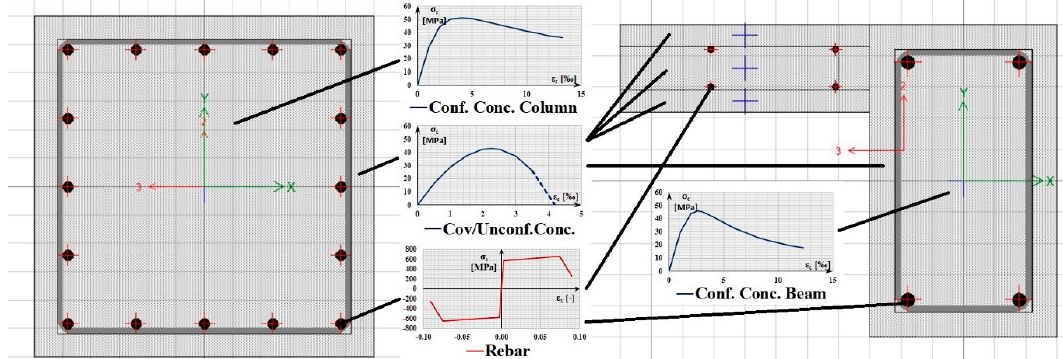
Figure 8. Schematic representation of column ( left ) and L beam ( right ) auto-discretised sections with appropriate stress– strain properties depending on the material used [40].